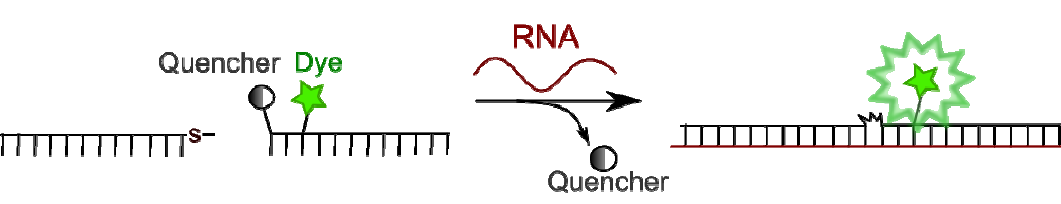
Figure 16. Quenched autoligation probes